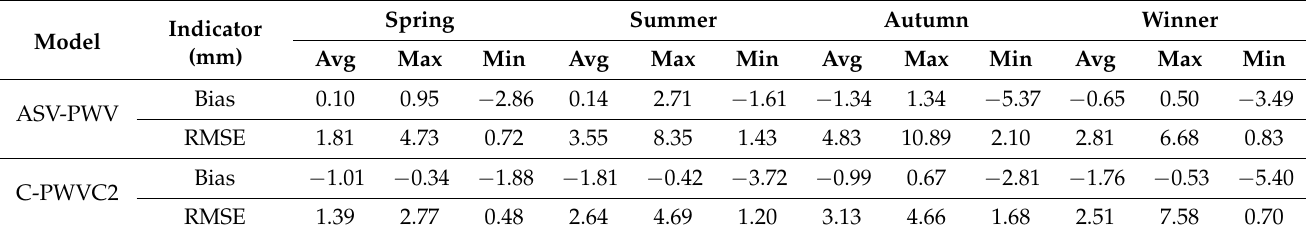
Table 2. Performance statistics of the ASV-PWV and C-PWVC2 in 4 seasons of